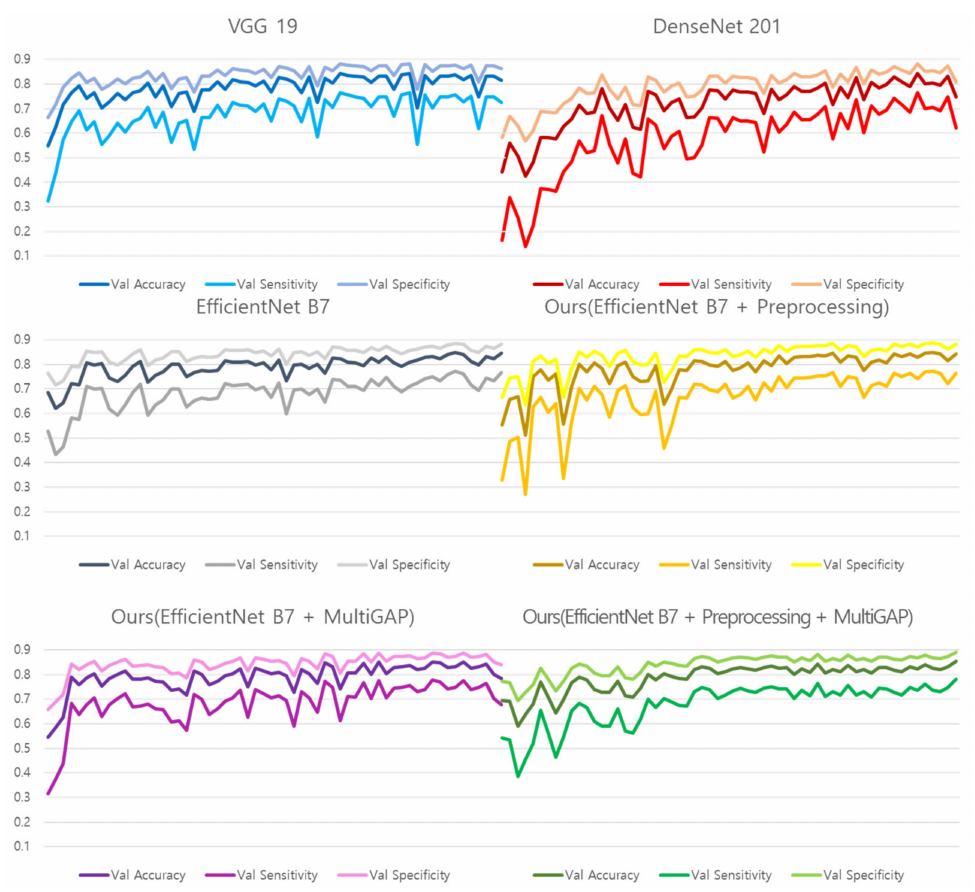
Figure 14. NIH dataset training graph.